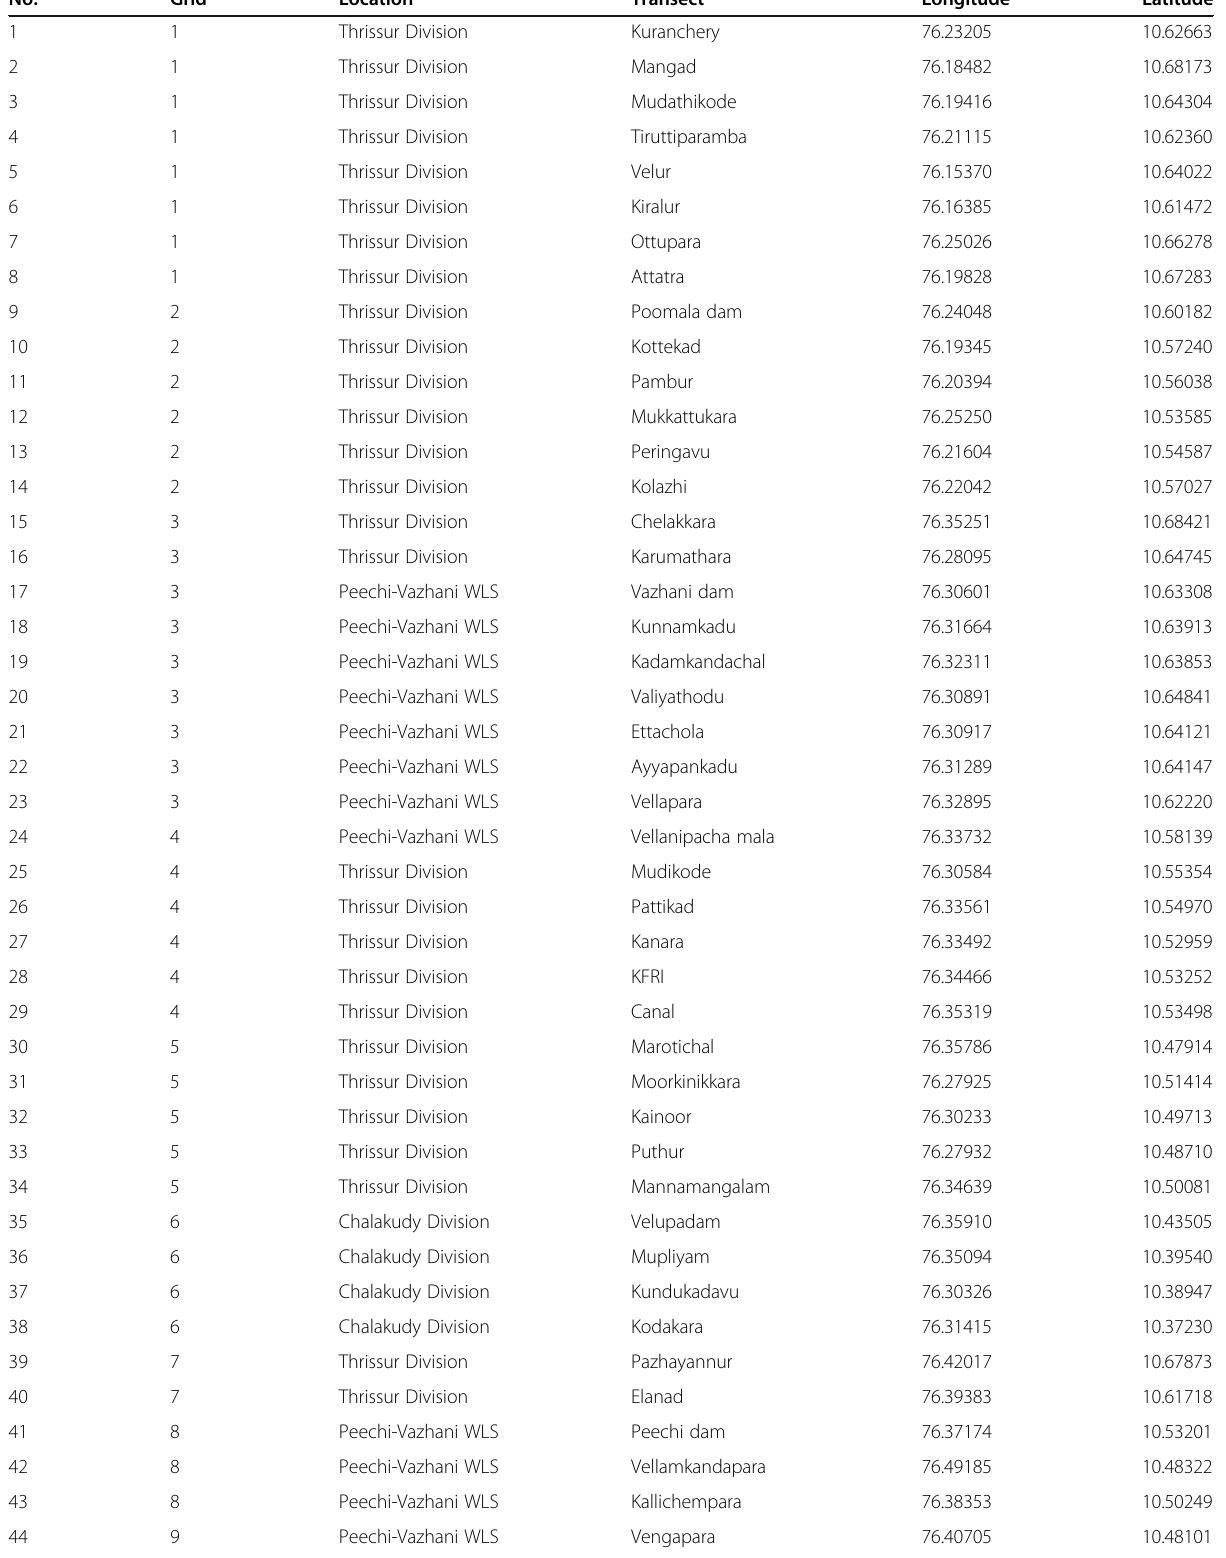
Table 1 Geographic coordinates of transects sampled in 30 grids of study area No. Grid Transect Longitude